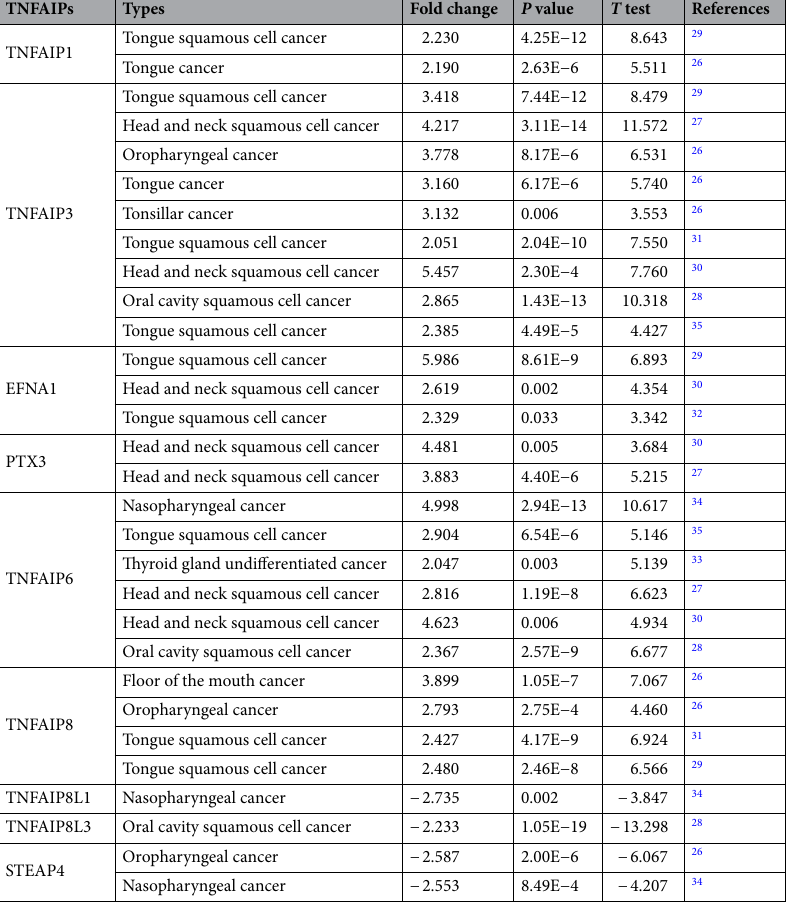
fold to 3.899-fold in tissues from 76 patients with HNC 26,29,31 . In contrast, the expression levels of TNFAIP8L1, TNFAIP8L3, and STEAP4 were downregulated, with fold changes of 2.735, 2.233, and 2.587, respectively, in 94 HNC samples 26,28,34 . However, the transcript levels of TNFAIP2 and TNFAIP8L2 were not significantly dif- ferent between cancer samples and normal samples. We further evaluated the expression levels of TNFAIPs in 520 HNC and 44 normal samples by the UALCAN database. As expected, the transcript levels of TNFAIP1, reduced (Fig. 2, all P < 0.05). On the other hand, the Human Protein Atlas database was used to evaluate the protein expression levels of TNFAIPs in head and neck squamous cancer (HNSC) and normal tissues by immunohistochemistry, and the results are presented in Fig. 3. Based on the immunohistochemical staining images, the protein expression levels of TNFAIP2, TNFAIP3, EFNA1, PTX3, TNFAIP6 and TNFAIP8 in HNSC samples were higher than those in normal samples, which was consistent with the transcriptomics results. The relationship between the mRNA levels of TNFAIPs and clinicopathological parameters in HNC patients. In the LinkedOmics portal, the nonparametric test was performed to compare the mRNA expression of TNFAIPs between patients grouped according to clinicopathological parameters such as T stage (448 patients), N stage (411 patients), M stage (182 patients), pathologic stage (439 patients), and radiother- apy status (451 patients) (Supplementary Table S1). The transcript levels of EFNA1 ( P = 4.09E−04) were sig- nificantly elevated, while the levels of TNFAIP8 ( P = 3.42E−02), TNFAIP8L2 ( P = 1.68E−03), and TNFAIP8L3